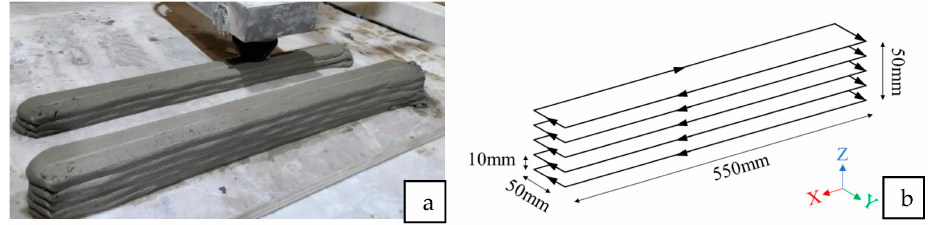
Figure 4. ( a ) Printed block for mechanical analysis; ( b ) print path of the printed block with dimensions.